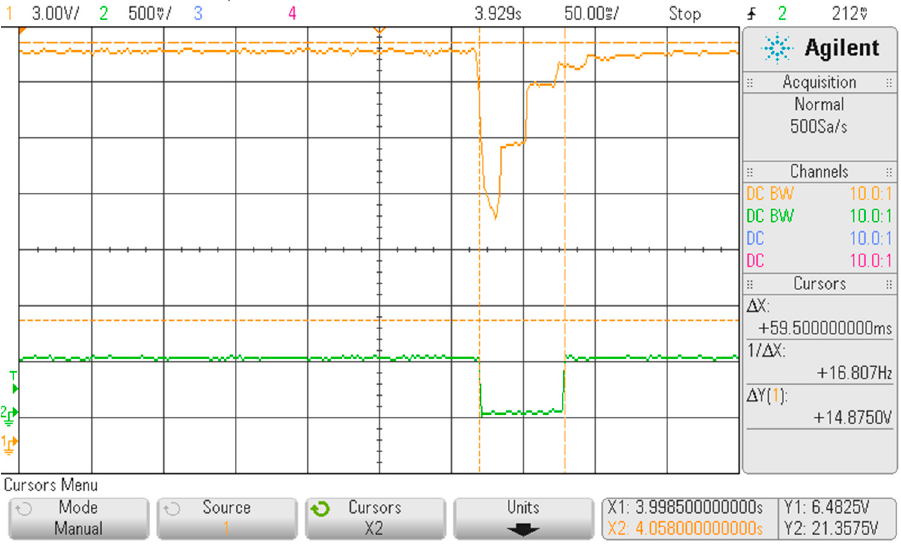
Figure 10. Detail of Figure 10, representing the transition phase when the relay is excited.